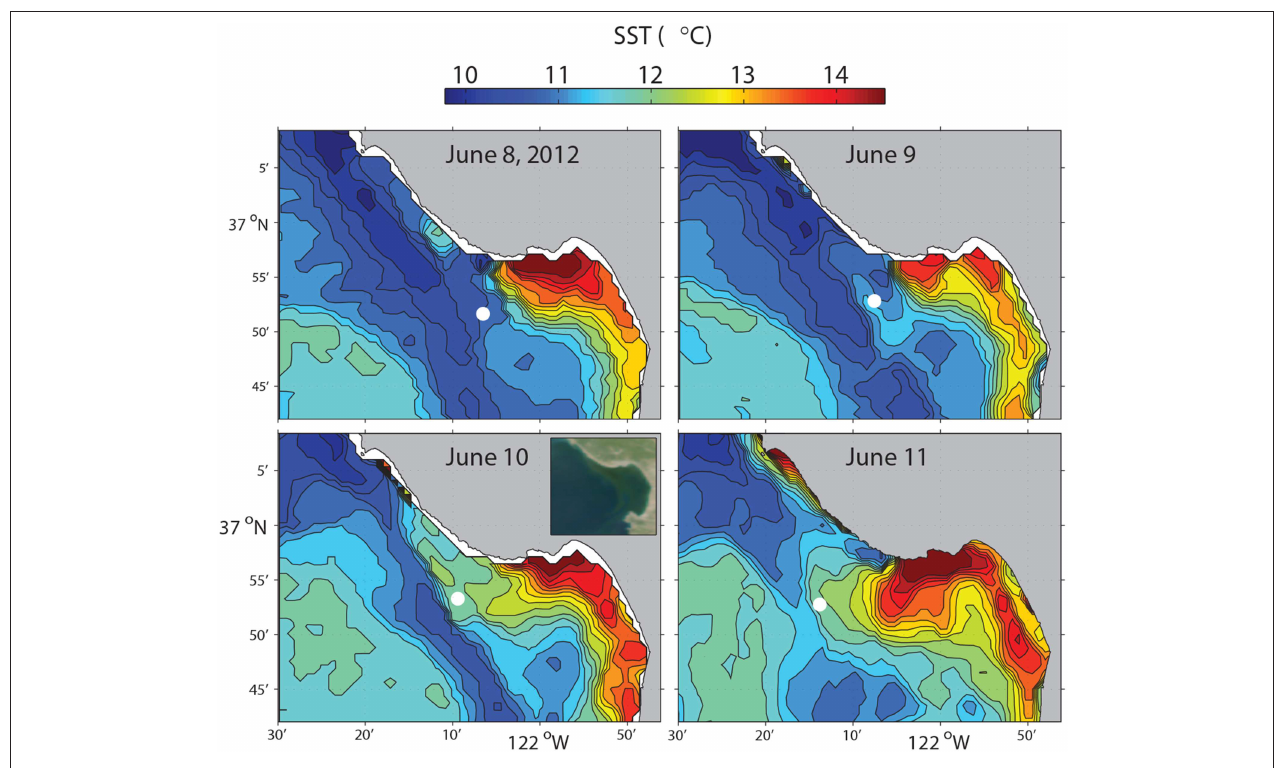
FIGURE 6 | Satellite SST of Monterey Bay on 08-Jun 21:09, 09-Jun 22:30, 10-Jun 22:09, 11-Jun 21:48 (PDT), 2012. The circles mark the LRAUV-tracked front locations which were within 4 h of each SST acquisition time. Satellite ocean color at 10-Jun 12:54 (PDT) is shown in the inset in the lower-left panel. Reused from Zhang et al. (2015) with